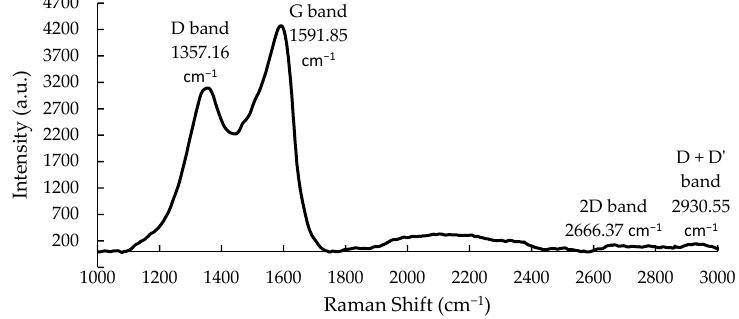
Figure 2. The Raman spectrum of vacuum annealed Pt-GO-LCM sample.